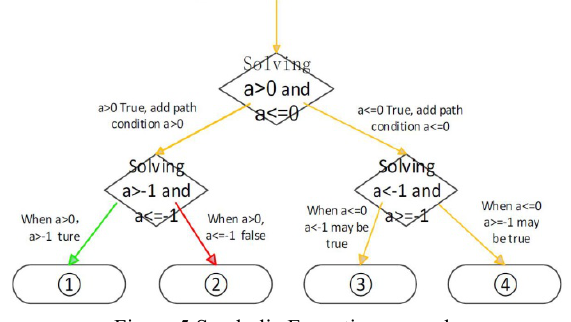
Figure 5 Symbolic Execution